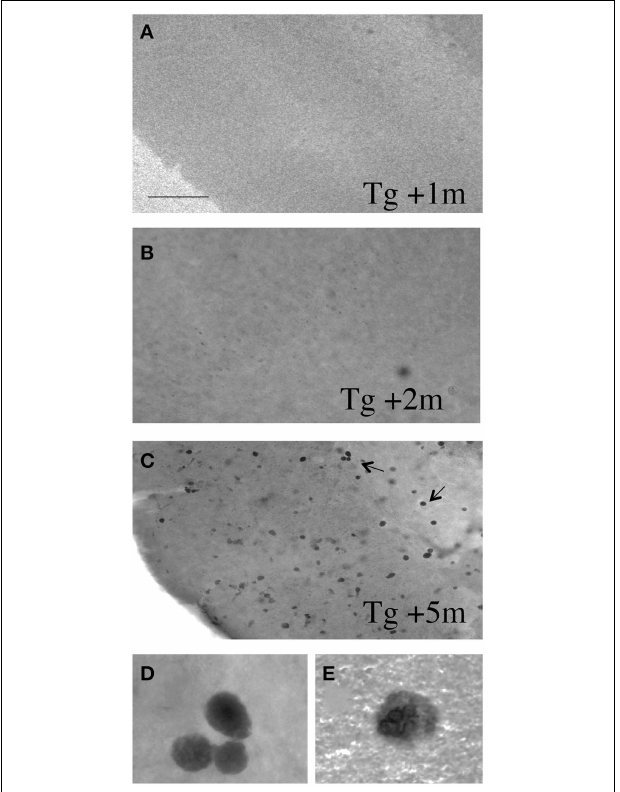
FIGURE 3 | Vibrosections from 4 month old APP_SDI mice (having no plaques at this stage) were incubated for 1 (A), 2 (B), or 5 (C–E) months, then fixed and stained for A β . No staining was visible after 1 or 2 months of incubation, however, after 3 and more pronounced after 4 and 5 months several A β + intracellular depositions were seen. The 2 pictures in the last row (D,E) show high magnifications taken from panel (C) . However, at any stage no extracellular plaques were found. Scale bar in A = 200 µ m (A–C) and 12 µ m (D,E) .